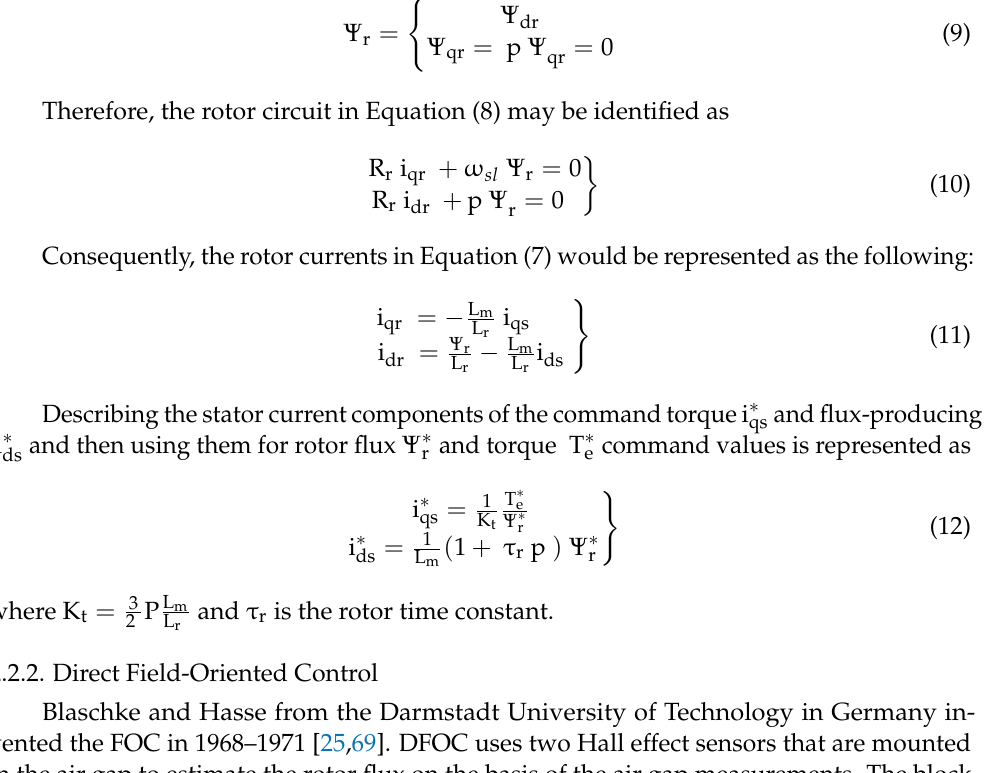
( b ) Figure 5. ( a ). Block diagram of DFOC via flux sensor for IM drive. ( b ). Block diagram of DFOC via rotor flux estimator or observer for IM drive. The dynamic performances of the DFOC method (based on Figure 5b with RFO) are presented in Figures 6–8 (tested motor parameters are mentioned in Table 1). Via the Matlab/Simulink package, where the motor velocity is kept constant at (10 rpm) and the load torque is assumed to be constant at the rated value (7 Nm) , nominal motor parame- ters are assumed. Results show that the actual speed can track the command velocity tra- jectory; the velocity error among the actual and command velocities is small. In spite of the fact that the current is nearly sinusoidal, it contains some ripples that can be a(cid:308)ributed to the PWM system. One of the largest ripples is presented in the d-axis flux component,